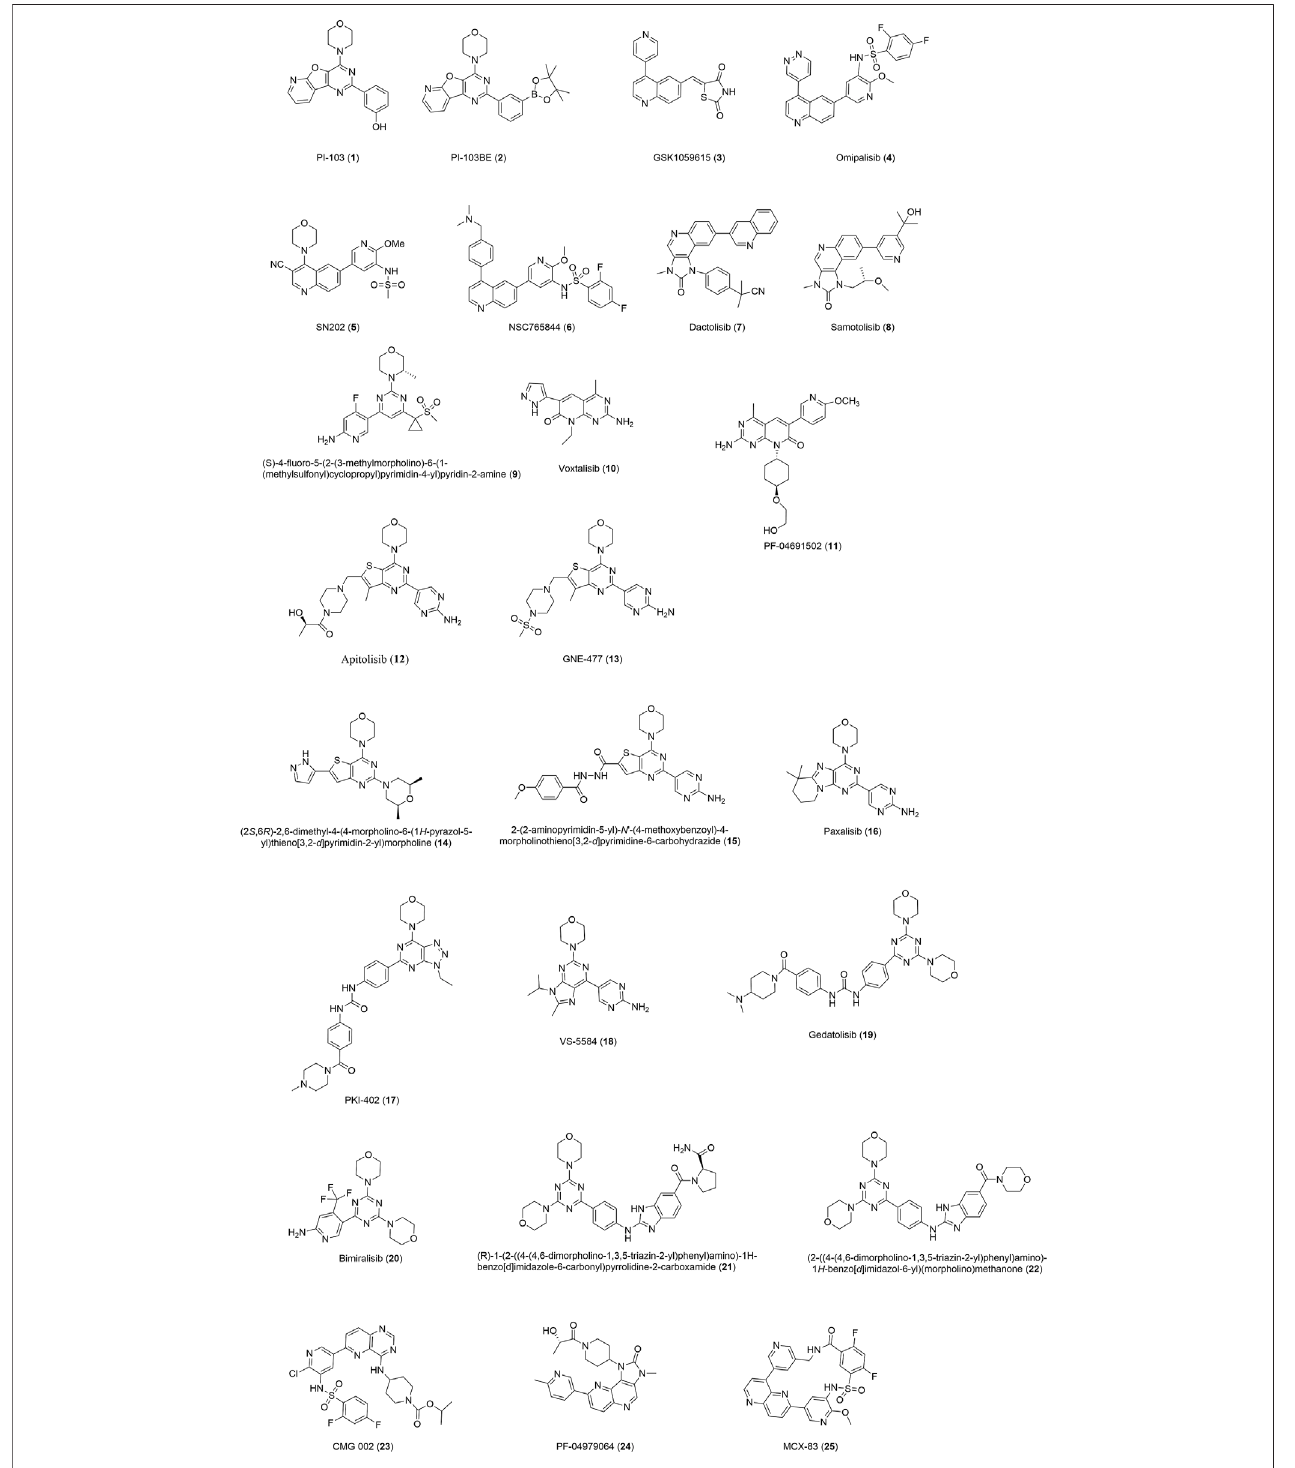
FIGURE 2 | Structures of dual PI3K/mTOR inhibitors mentioned in the